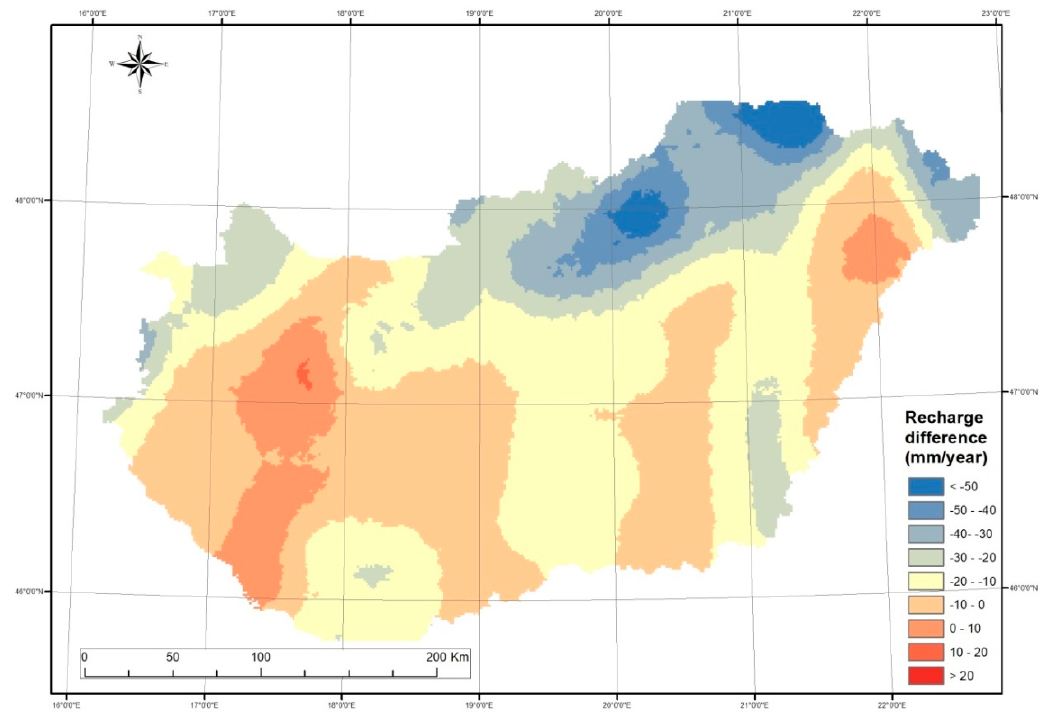
Figure 10. Simulated difference in groundwater recharge between 2071–2100 and 1961–1990 averages based on ALADIN model results.